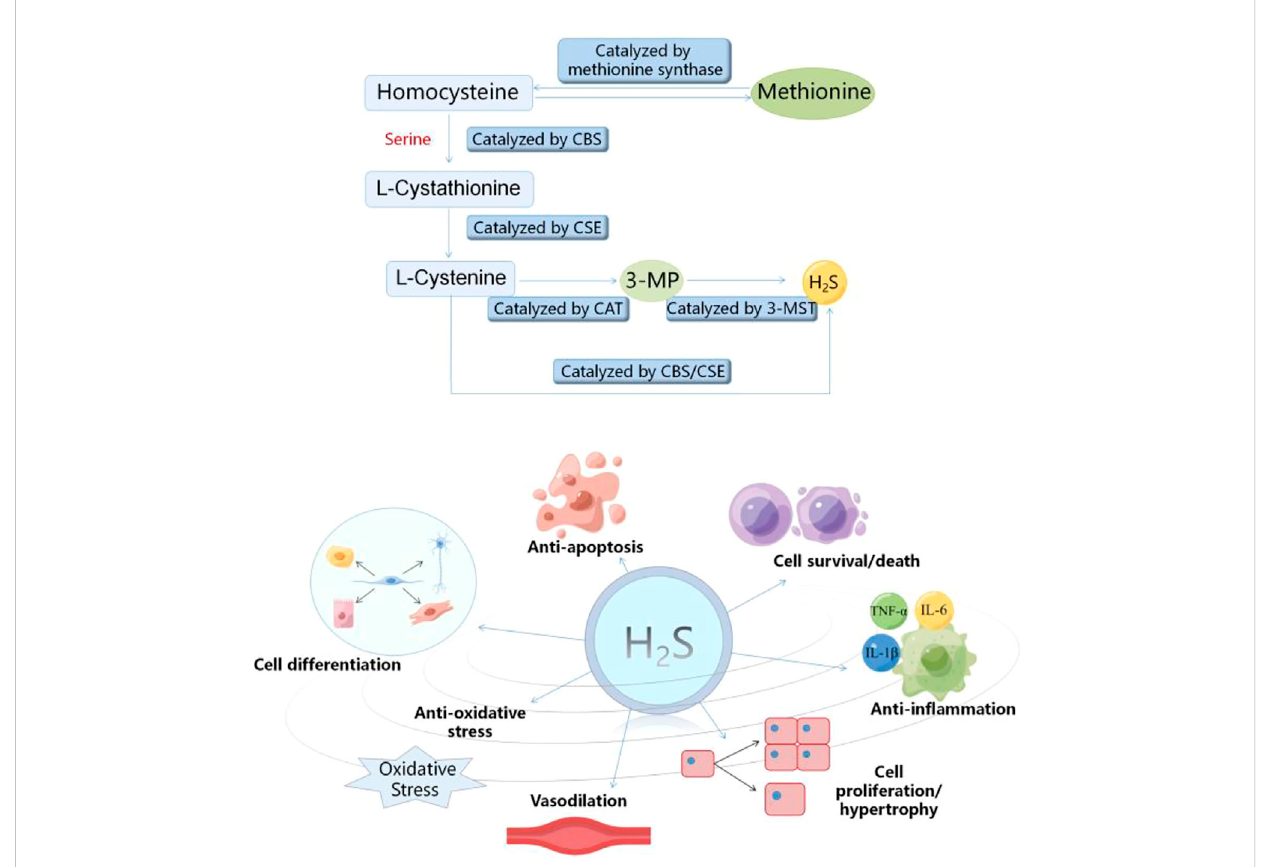
FIGURE 2 Diagramofendogenoushydrogensul fi deproductionprocessanditsbiologicaleffects.CSE,cystathionine- γ -lyase;CBS,cystathionine- β -synthase; 3-MST, 3-mercaptopyruvate sulfurtransferase.